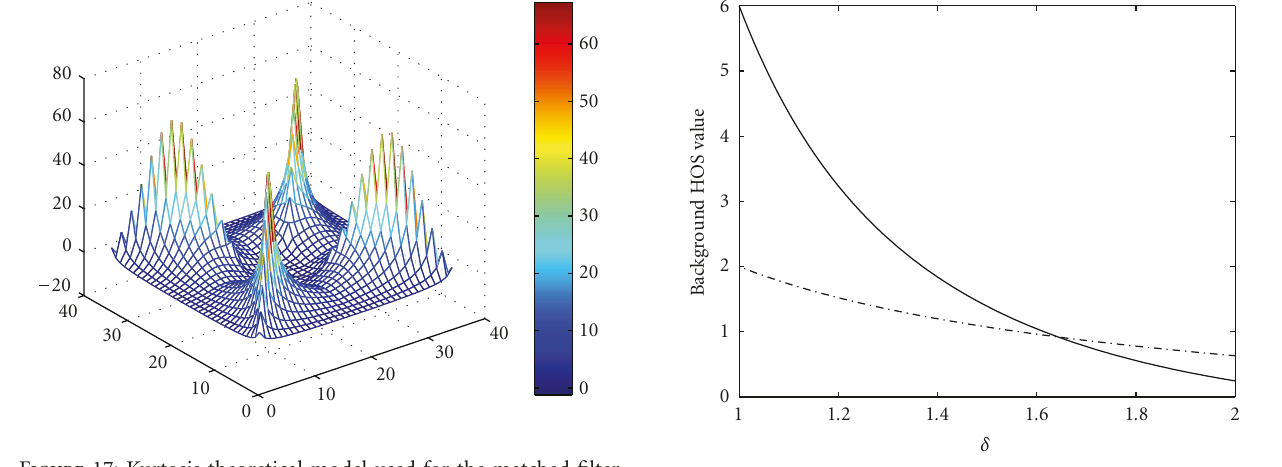
Figure 17: Kurtosis theoretical model used for the matched filter (mean window size 23 × 23, SD = 3).